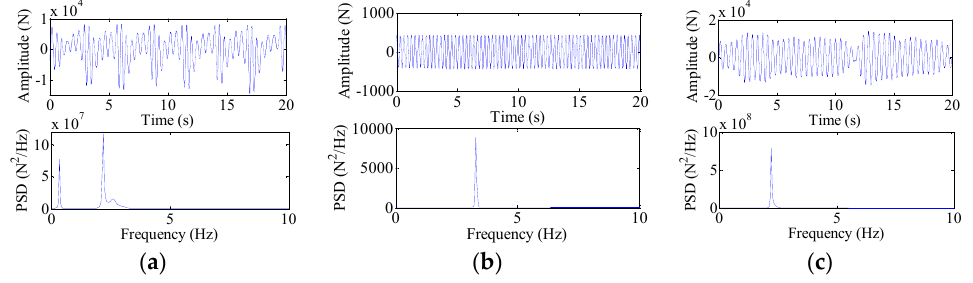
Figure 7. Fluctuation characteristic of F X acting on the wind rotor in different parking positions when the wind direction is β = 105 ˝ : ( a ) θ = 0 ˝ parking position; ( b ) θ = 30 ˝ parking position; ( c ) θ = 60 ˝ parking position.